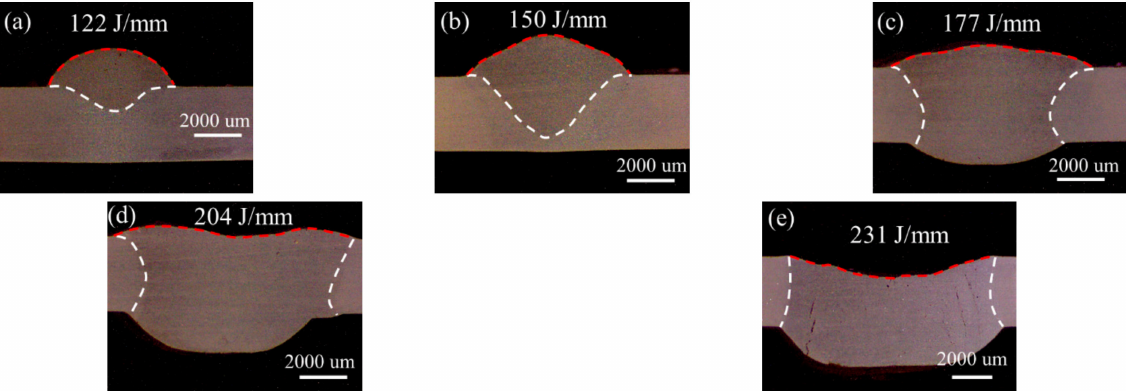
Figure 5. Corresponding bead profile for each heat input: ( a ) 0.12 kJ/mm; ( b ) 0.15 kJ/mm; ( c ) 0.18 kJ/mm; ( d ) 0. 20 kJ/mm; ( e ) 0.23